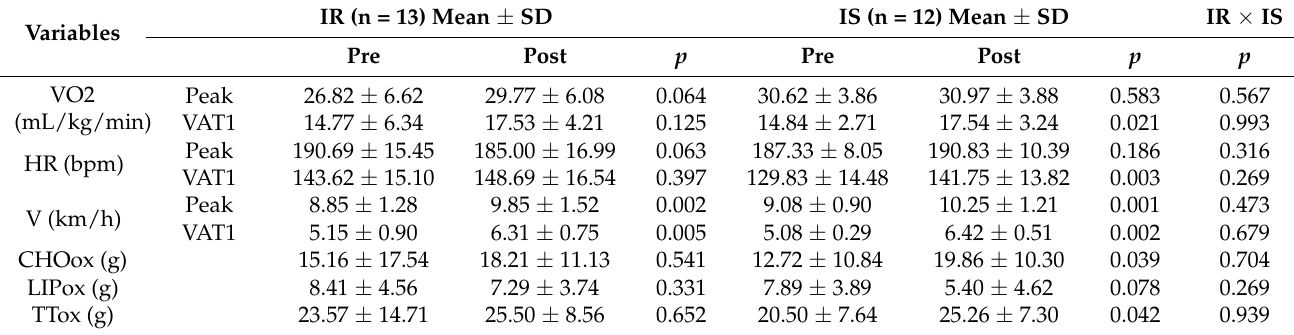
Table 2. Pre- and post-training mean values in the insulin-resistant (IR) group and insulin-sensitive (IS) group, for peak intensities and VAT1 and substrate oxidation during indirect